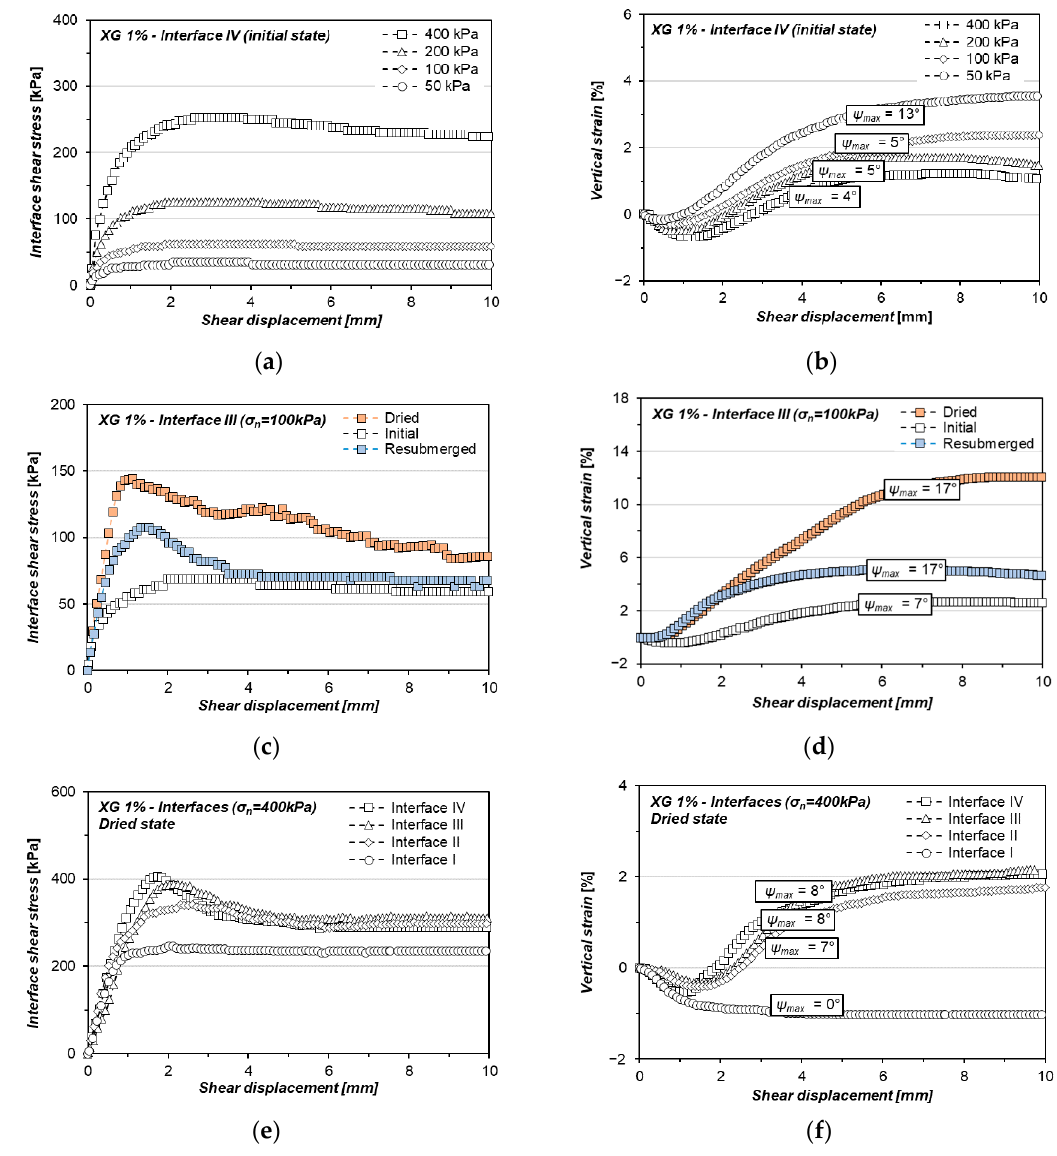
Figure 9. Interfacial shear test results of xanthan gum-treated soil shearing including asperity (interfaces II, III, IV): ( a , c , e ) interface shear stress ( τ )-horizontal shear displacement ( δ ) curves; ( b , d , f ) vertical strain ( ε v )-horizontal shear displacement ( δ ) curves.